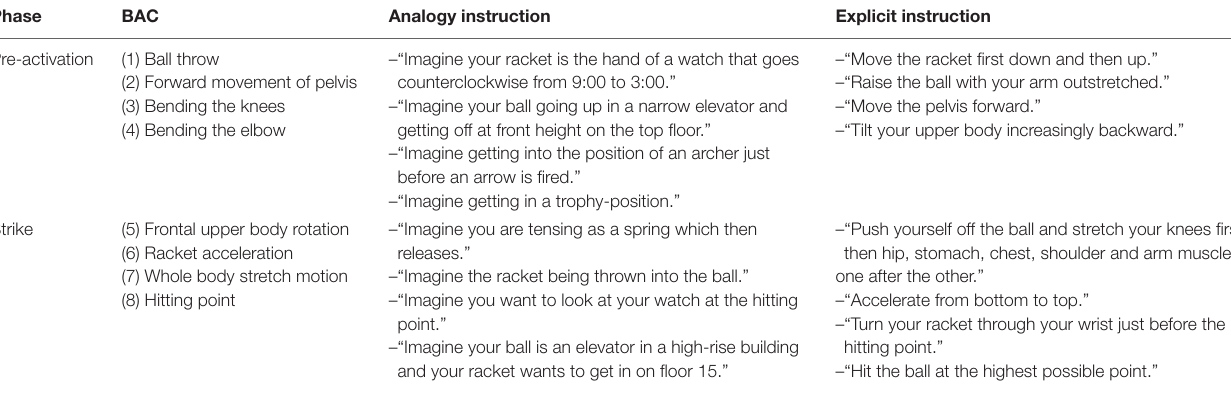
TABLE 1 | Analogy Instructions and explicit instructions for each movement phase [adapted from Meier et al. (2019)]. Phase BAC Analogy instruction Explicit instruction